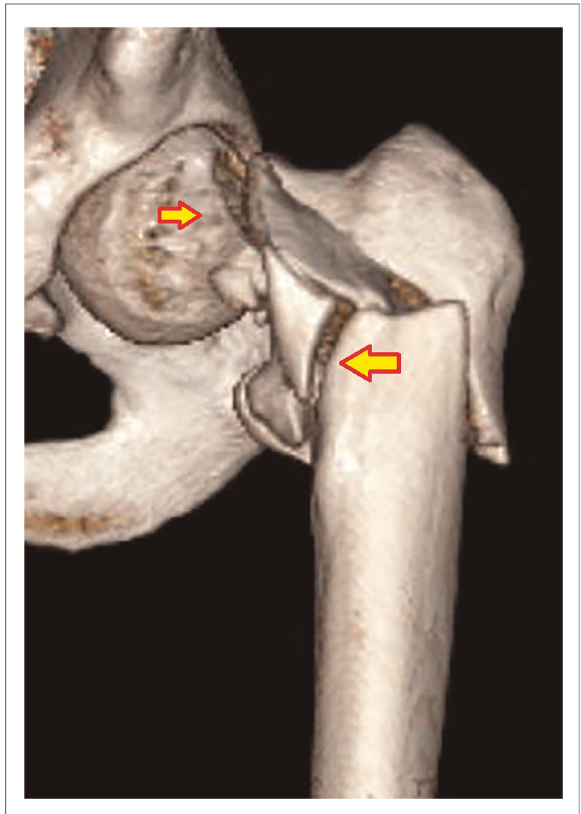
FIGURE 14 Subtype A4.4, concomitant ipsilateral segmental fractures involving both femoral neck and trochanteric region. The arrows indicate subcapital neck fracture and comminuted transtrochanteric